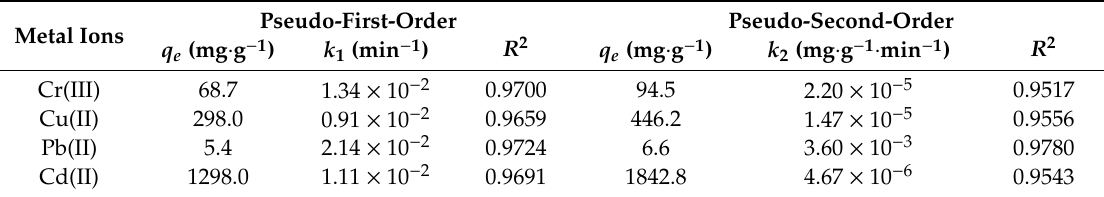
Table 1. Adsorption kinetic parameters of the Fe 3 O 4 @Me 6 TREN NPs for Cr(III), Cu(II), Pb(II), and Cd(II) ions.